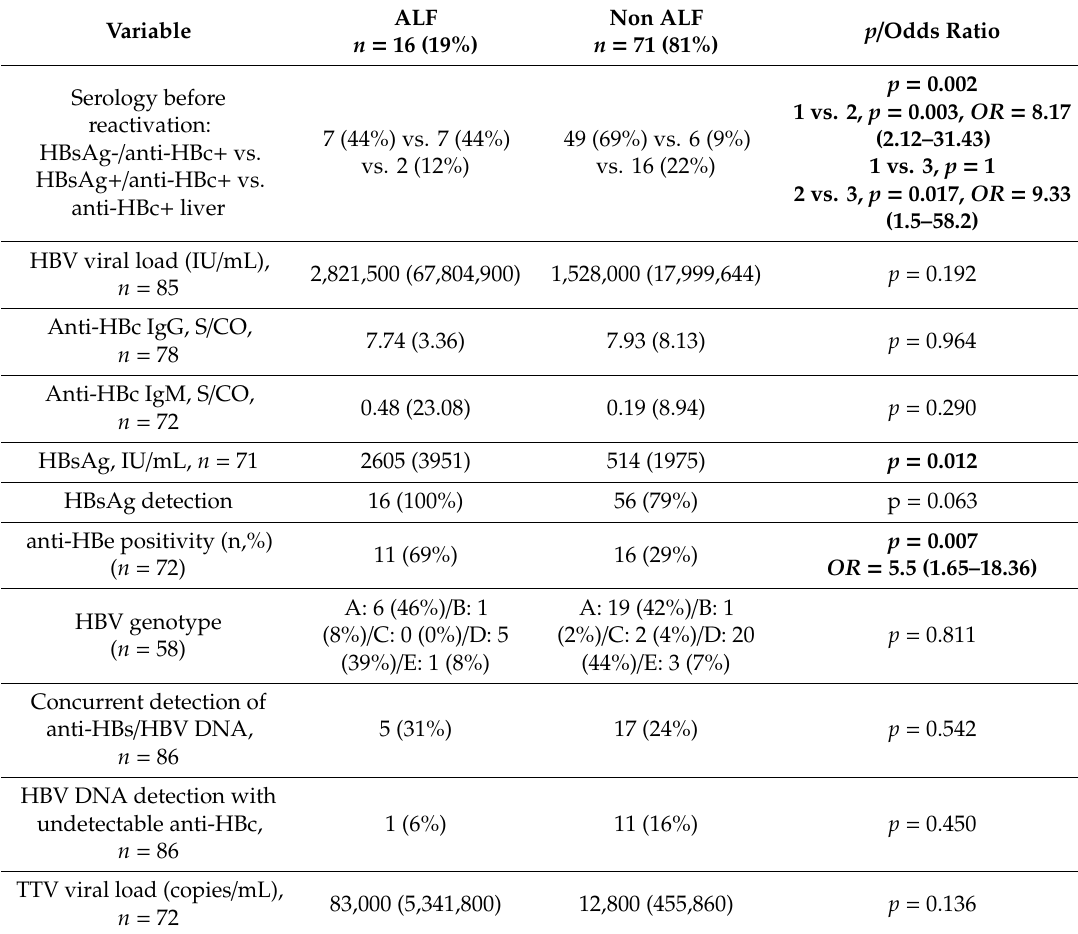
Table 2. Serological and virological parameters of patients with HBV reactivation stratified according to their liver function: ALF vs. non-ALF